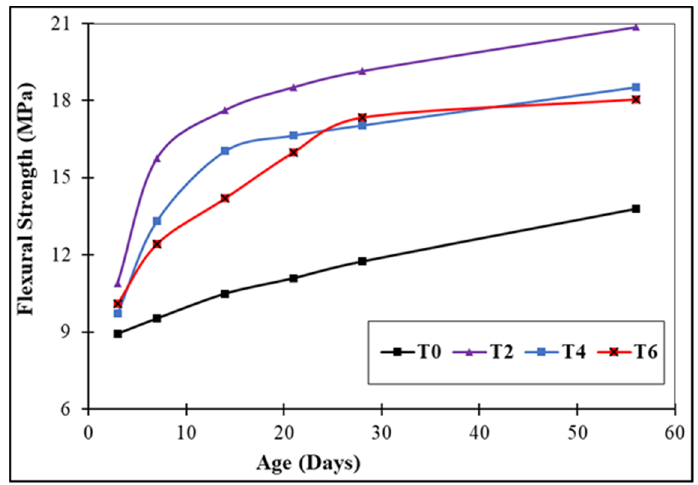
Figure 5. Flexural strength of mortar composites with varying fly ash and silica fume content.